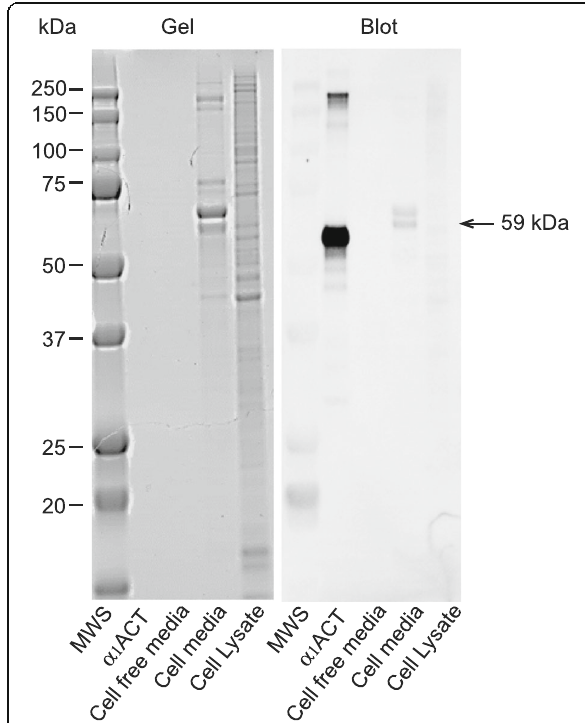
Fig. 9 Representative SDS PAGE gel and immunoblot showing alpha-1-antichymotrypsin ( α 1 AC), secreted into the media from N42 neuronal cells. No bands are visible with media alone. The blot shows two immunoreactive bands in the media from N42